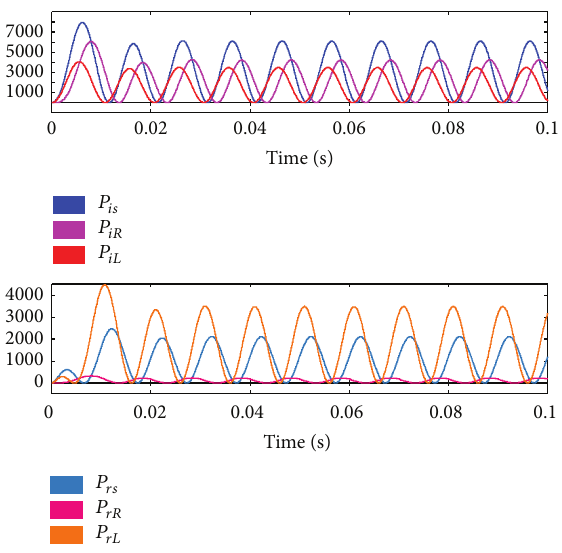
Figure 11: Power waves responses in the VRL circuit.